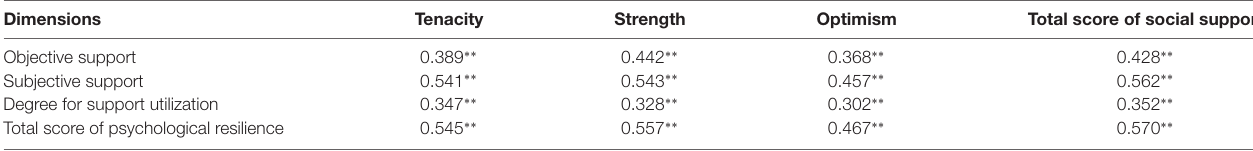
TABLE 7 | Correlation between total scores of psychological resilience and social support in patients with complicated hepatolithiasis ( r ). Dimensions